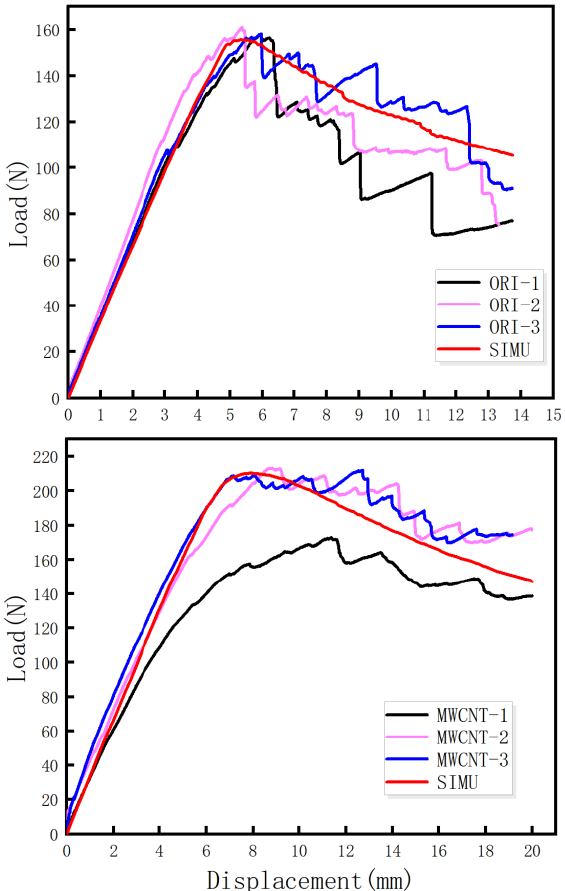
Figure 11. Load-displacement comparison between the experiment and the simulation of the original and MWCNTs toughening specimens.